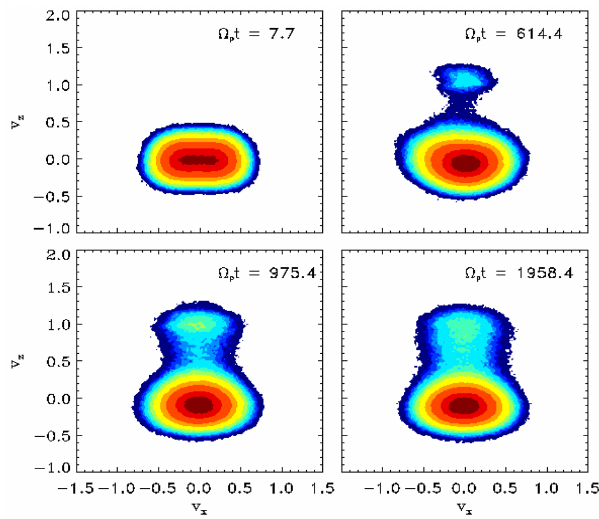
Figure 14. Contour plots of proton VDFs in the (v x ,v z ) velocity plane after Araneda et al. (2008). These VDFs originated in a sim- ulation run for a dispersive Alfvén pump wave and refer to four instants of time. The color coding of the contours corresponds to 75% (dark red), 50% (red) and 10% (yellow) of the maximum of the VDF, with a final proton beam density of about